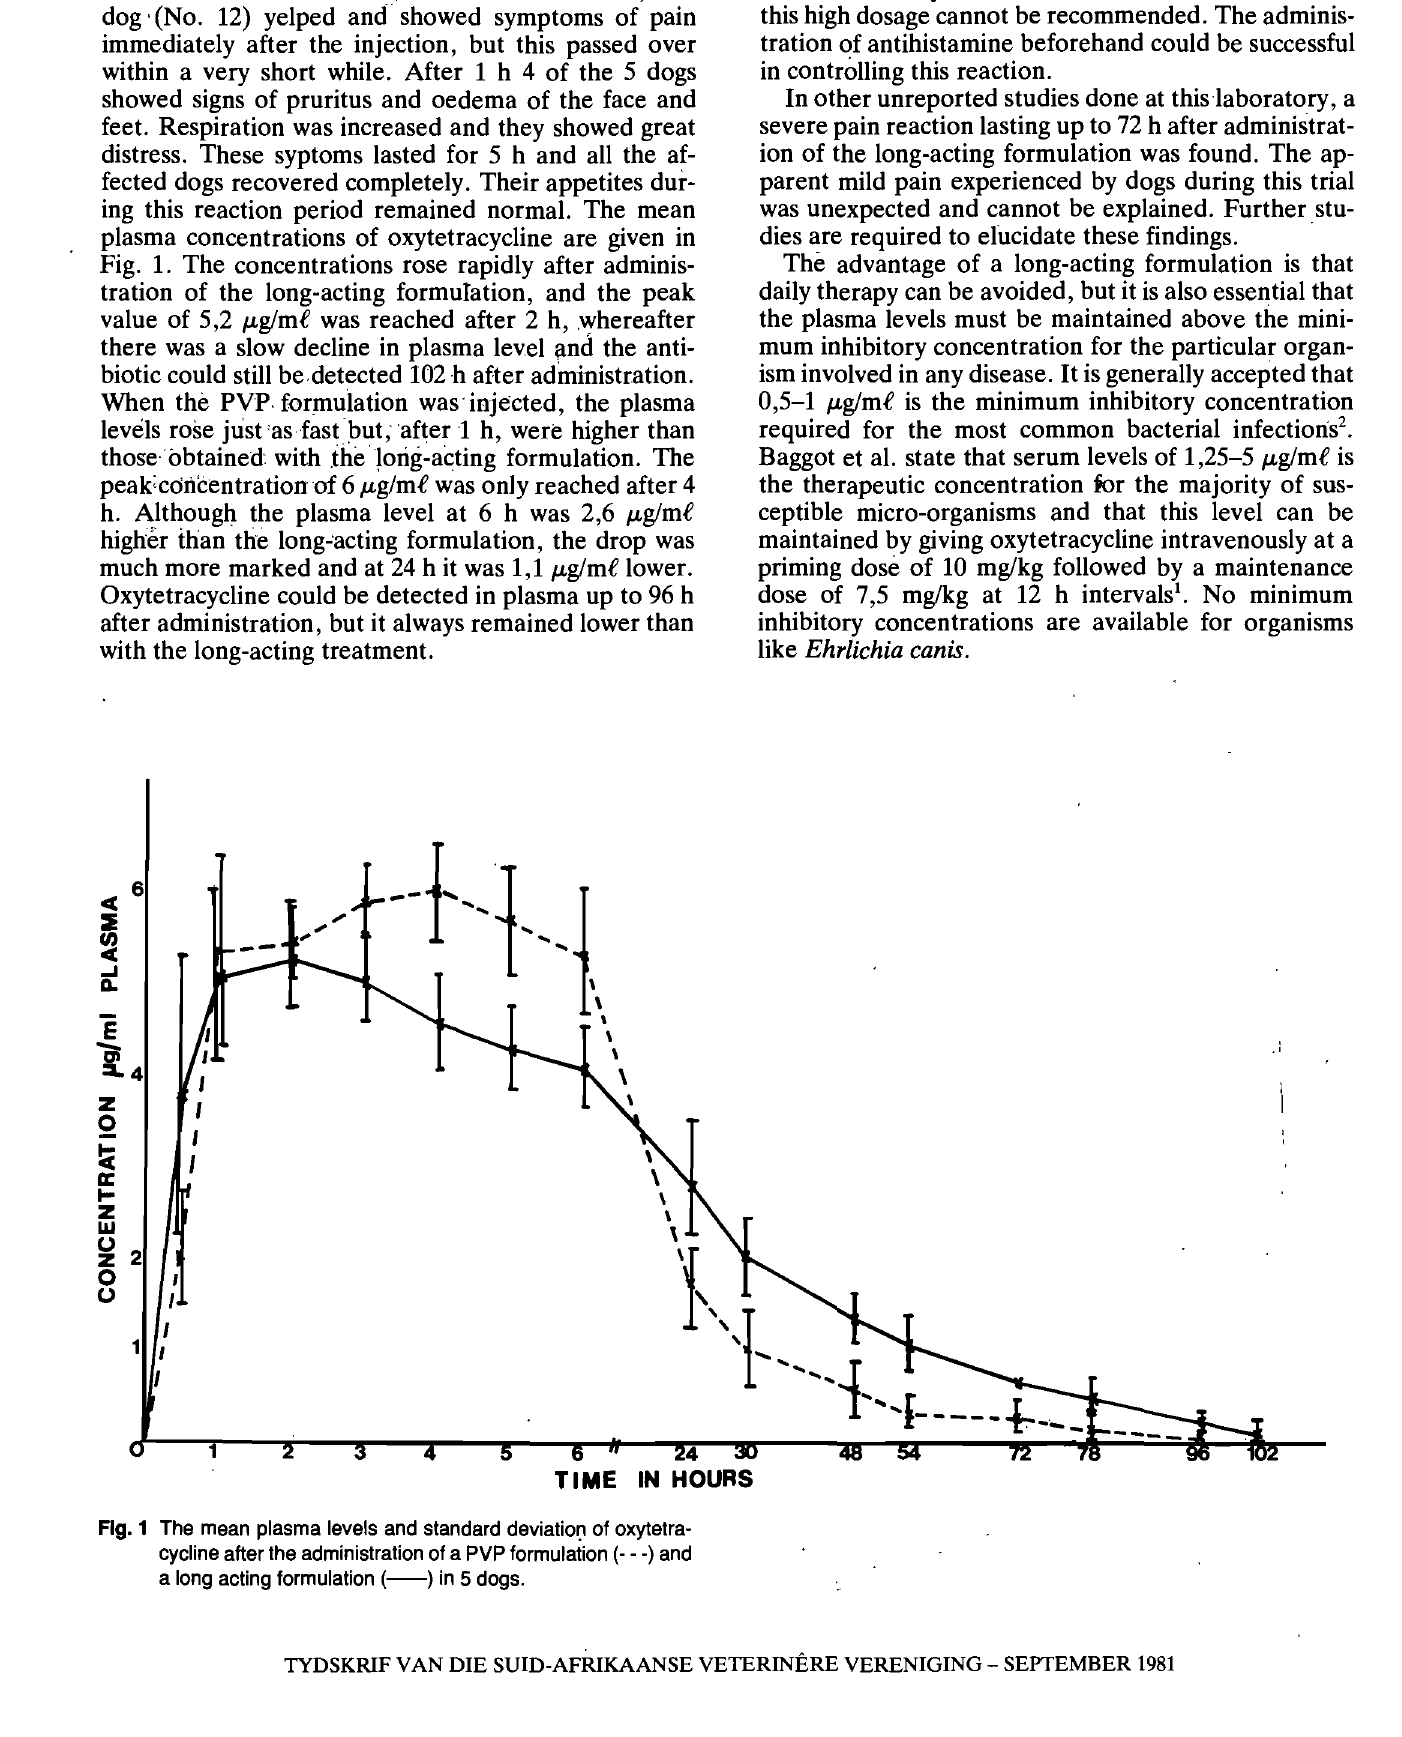
Fig. 1 The mean plasma levels and standard deviatio~ of oxytetra cycline after the administration of a PVP formulation (- - -) and a long acting formulation (-) in 5